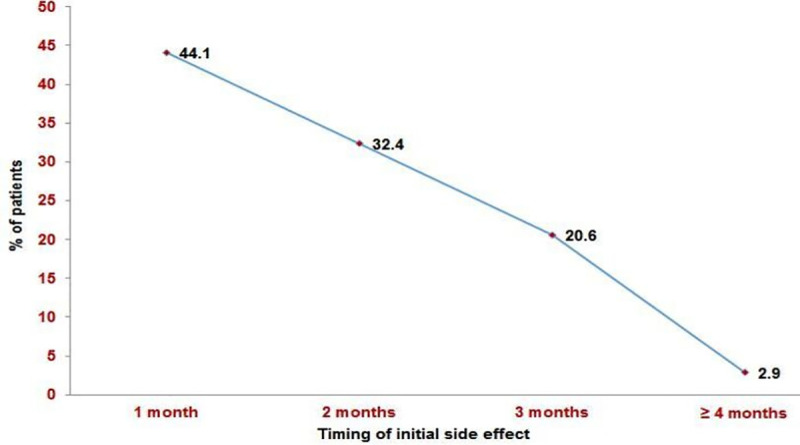
Timing of initial side effects during treatment.